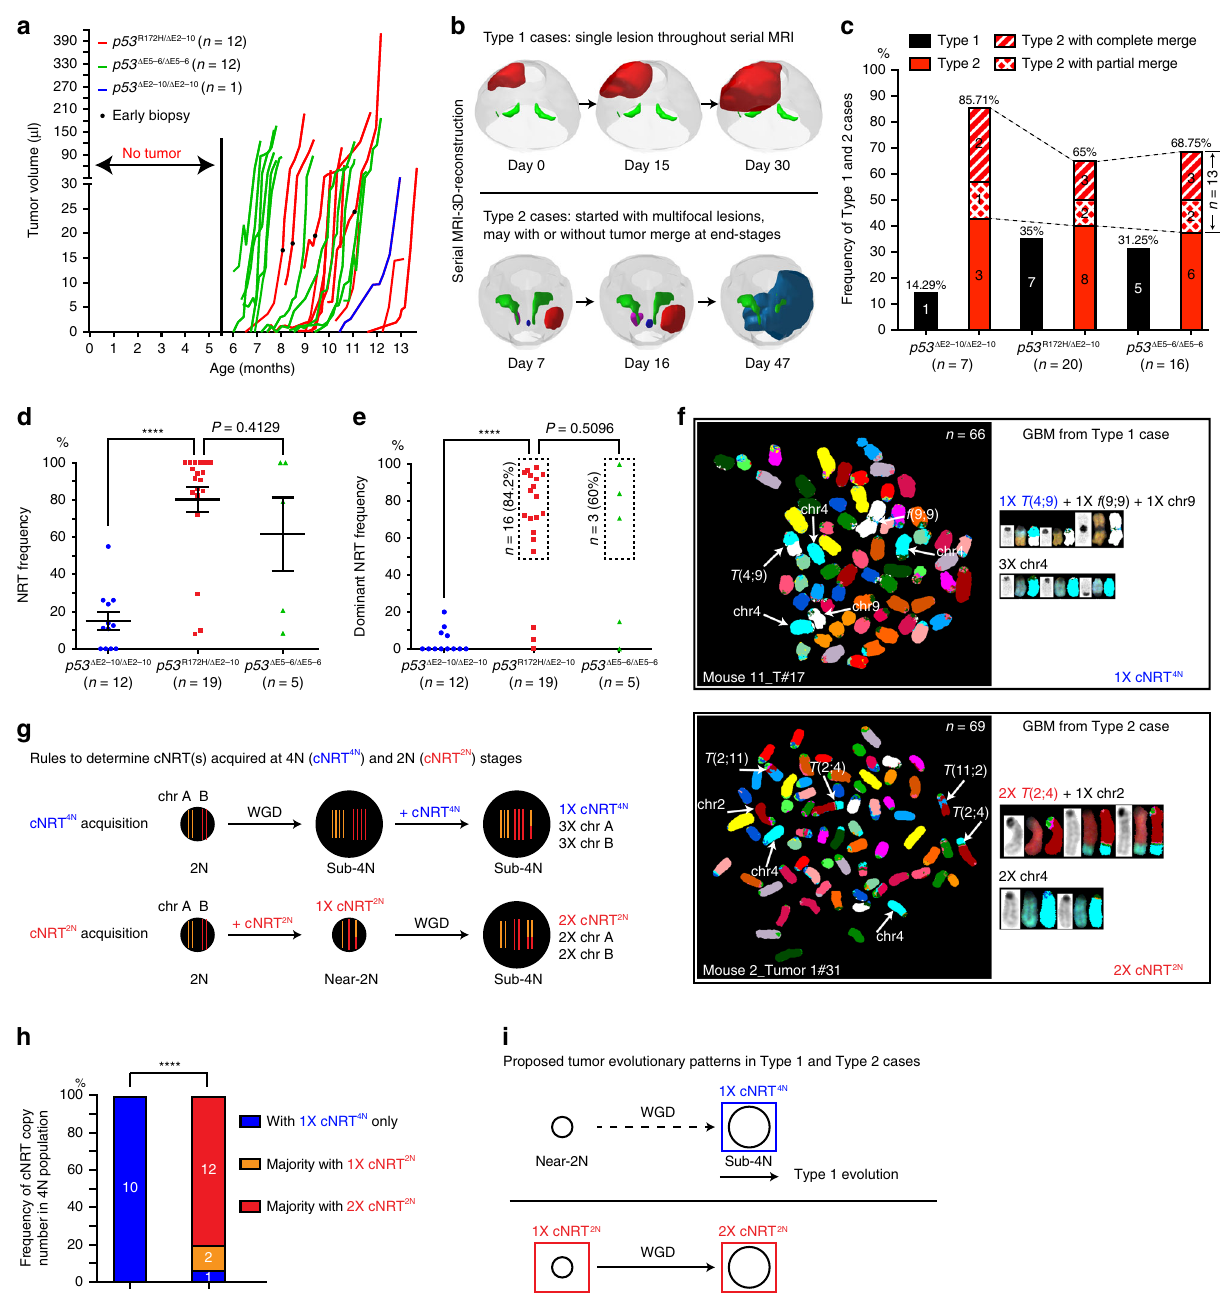
Fig. 2 Two growth patterns are associated with two cNRT acquisition patterns. a In vivo tumor growth curves of three p53 CKO models were determined by serial MRI. In mice with multifocal masses, the fastest-growing tumor is shown. b Representative 3D-reconstruction of MRI images shows the single- mass Type 1 (upper panel) and multifocal-mass Type 2 (bottom panel) growth patterns. c Frequency of Type 1 and Type 2 growth patterns in three p53 CKO models was determined by serial MRI. The single-mass Type 1 pattern was marked by black. The multifocal-mass Type 2 pattern was presented by three types: (1) no merge (red), (2) partial merge (red with diamonds), and (3) complete merge (could be misdiagnosed as Type 1, red with stripes). The percentage of cells from each tumor sample carrying a nonreciprocal translocation (NRT) ( d ) and the percentage of cells carrying the dominant NRT (the NRT with the highest frequency in a tumor sample) ( e ) were compared. Each dot represents a tumor sample. Data are presented as a dot plot with mean ± SEM. f Representative spectral karyotyping (SKY) images identify clonal NRT(s) (cNRTs, observed in over 50% of the metaphases analyzed in a given sample). Analysis of SKY images demonstrates that a sub-4N Type 1 tumor cell at end-stage contained only one copy of its cNRT (upper panel), while a sub-4N Type 2 tumor cell typically contained two copies of its cNRT (bottom panel). g Schematic illustration of a cNRT acquired in a cell with a 4N genome (cNRT 4N , blue) or acquired in a cell with a 2N genome (cNRT 2N , red). h The percentage of sub-4N tumors in Type 1 and Type 2 cases carrying cNRT 4N (s) and/or cNRT 2N (s) was shown. i Proposed tumor evolution patterns in Type 1 and Type 2 cases. Brie fl y, Type 1 tumors could only be traced back to a cNRT 4N -bearing cell with a sub-4N genome (blue square), while Type 2 tumors could be traced back to a cNRT 2N -bearing cell with a near-2N genome (red squares). Unpaired, two-tailed Student ’ s t test was used for statistical analysis in ( d , e , h ). **** p <